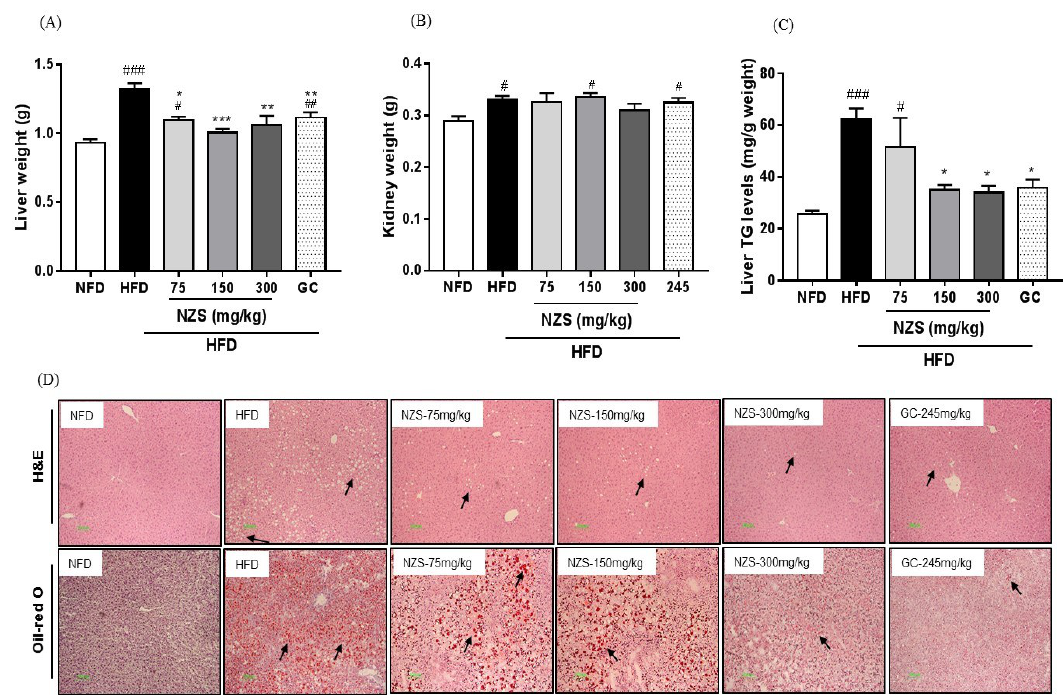
Figure 6. Effects of NZS on liver weight and hepatic lipid accumulation in HFD-induced obese mice. ( A ) Liver weight, ( B ) kidney weight, ( C ) liver TG levels, and ( D ) liver H&E and Oil-red O staining.